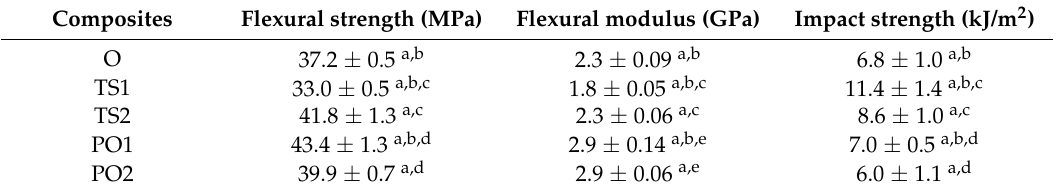
Table 1. Results of the analysis of variance for mechanical properties of pulp fiber/HDPE composites.